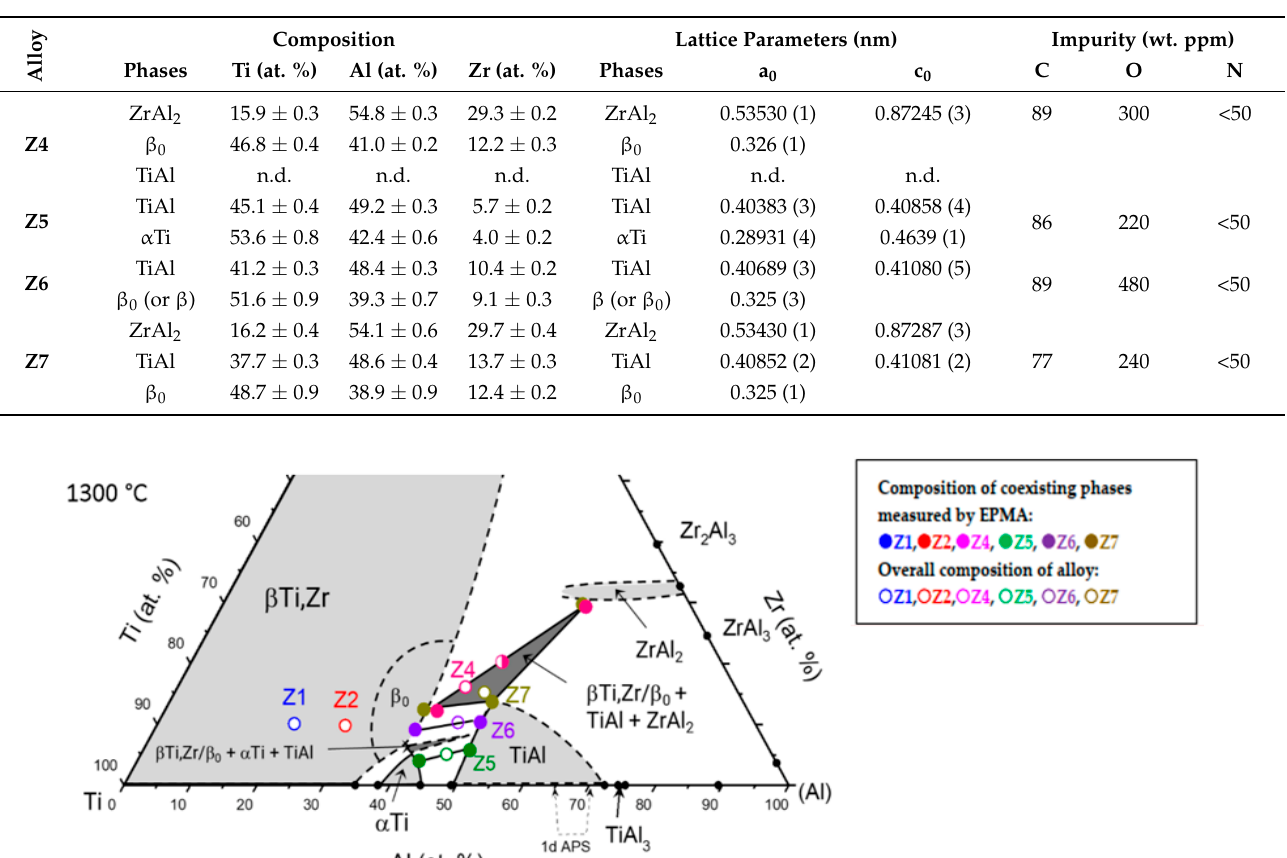
Table 6. Compositions and lattice parameters of the coexisting phases in alloys heat treated at 1300 °C/24 h; n.d.: not determined, but phase is detected.